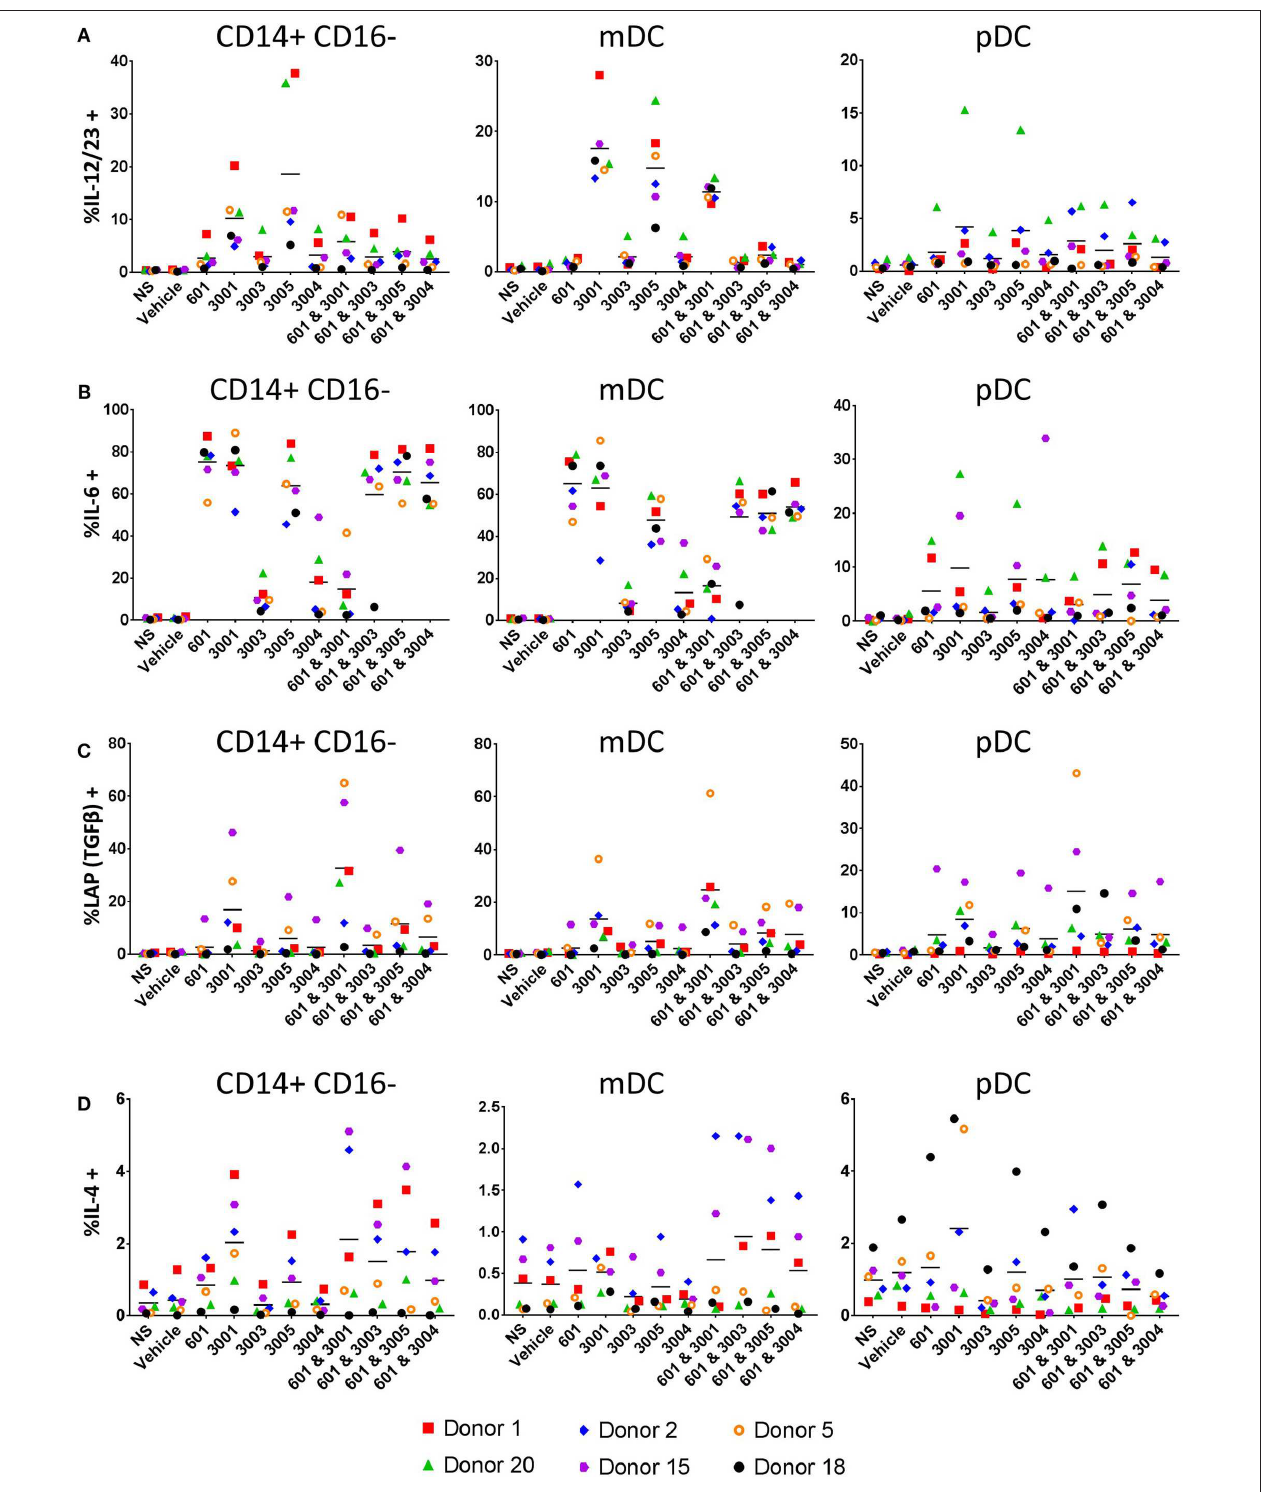
FIGURE 7 | Lipidated imidazoquinolines elicit T cell polarizing cytokines primarily from APCs. PBMCs from 6 healthy, adult blood donors were stimulated with 2 µ M indicated TLR7/8, TLR4, or combination TLR4 + TLR7/8 agonists. After 1h, brefeldin A (GolgiPlug) was added and cells were incubated for a further 5h. Cells were then harvested and stained with surface antibodies for phenotyping, fixed and permeablized and stained with antibodies to detect intracellular cytokines. (A) Frequency of IL-12/IL-23 + cells, (B) frequency of IL-6 + cells, (C) frequency of TGF β (LAP) + cells, and (D) frequency of IL-4 + cells.